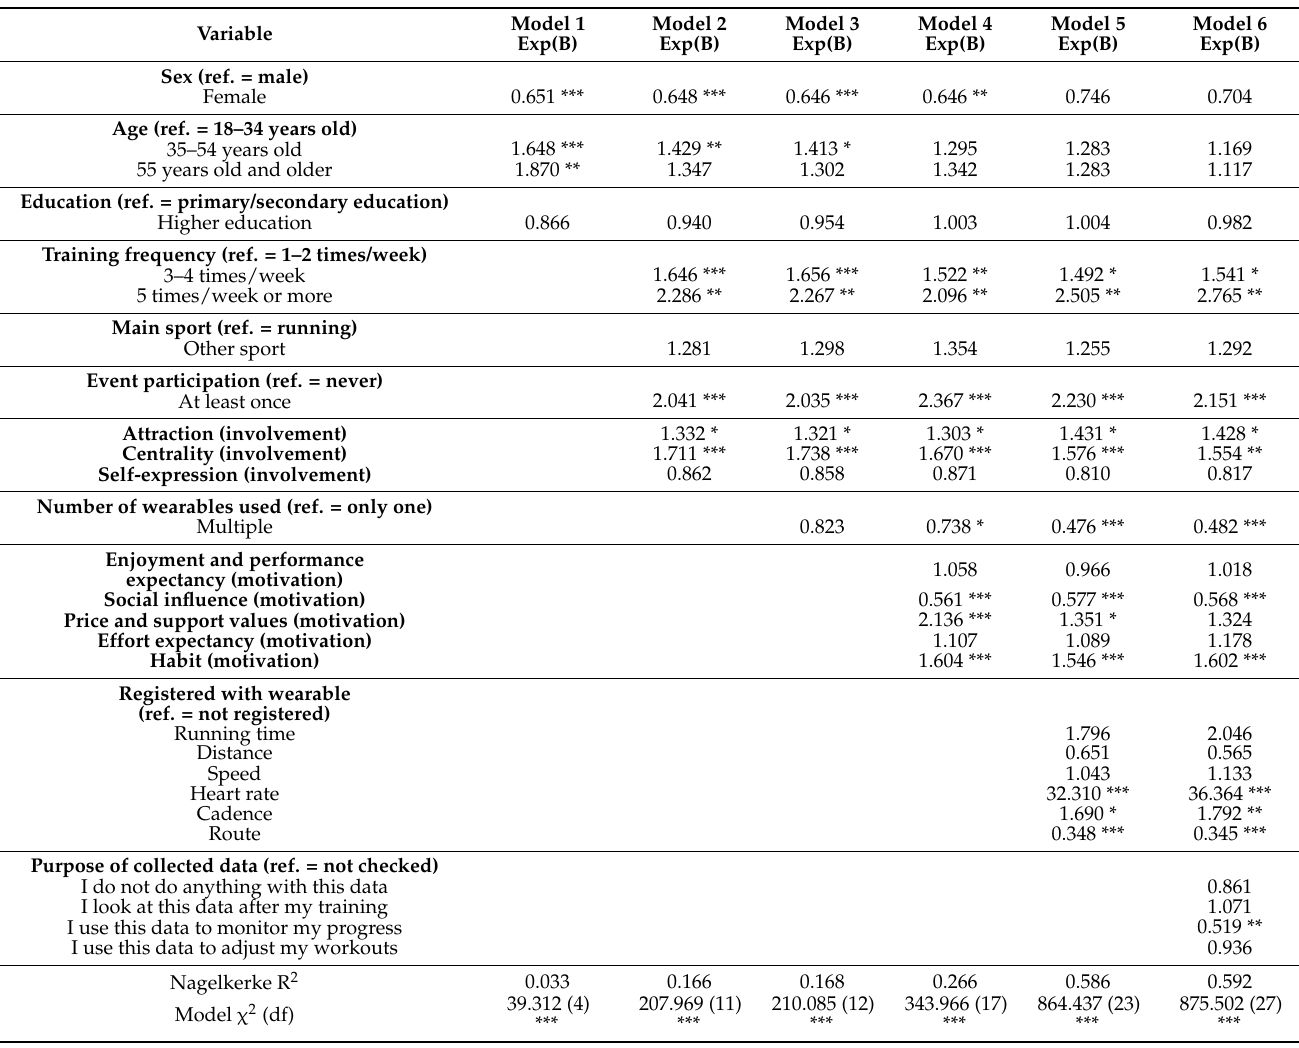
Table 5. Binary logistic regression for the most important wearable among running participants: use of applications (=0) or (sports)watches/smartwatches (=1) (N weighted =